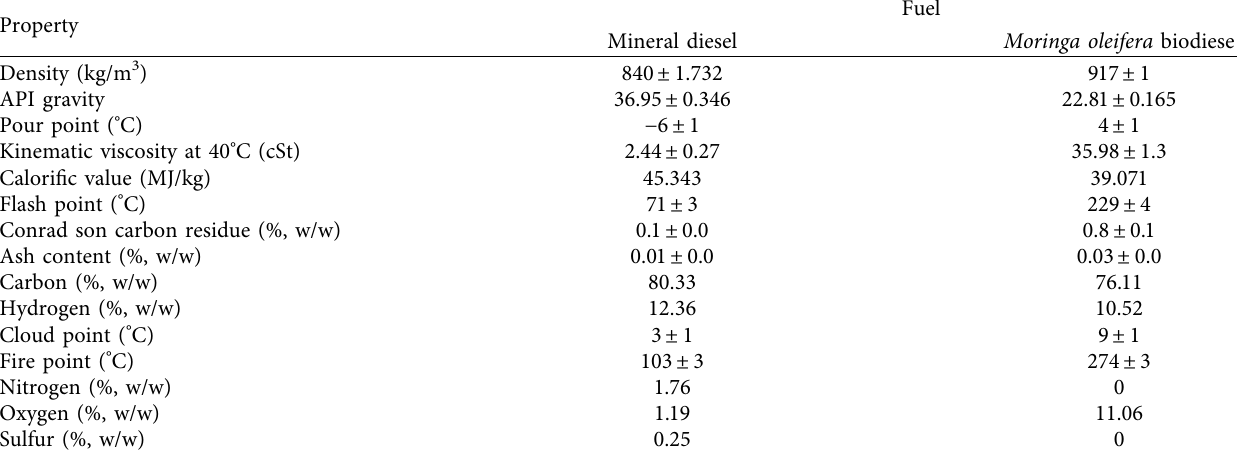
Table 8: Evaluated properties of mineral diesel and Moringa oleifera biodiesel as performed on the diesel engine [27]. Property